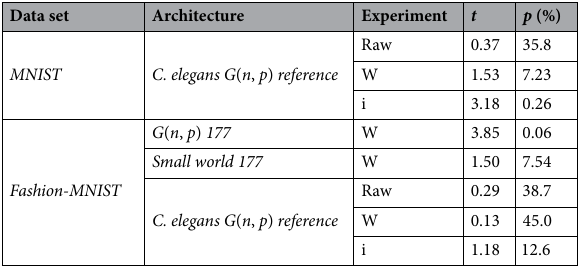
Table 4. Exceptions and alpha value inflation endangered cases for the accuracy t-test for ‘ C. elegans is the third best’. W—winning ticket, i—structure implantation.